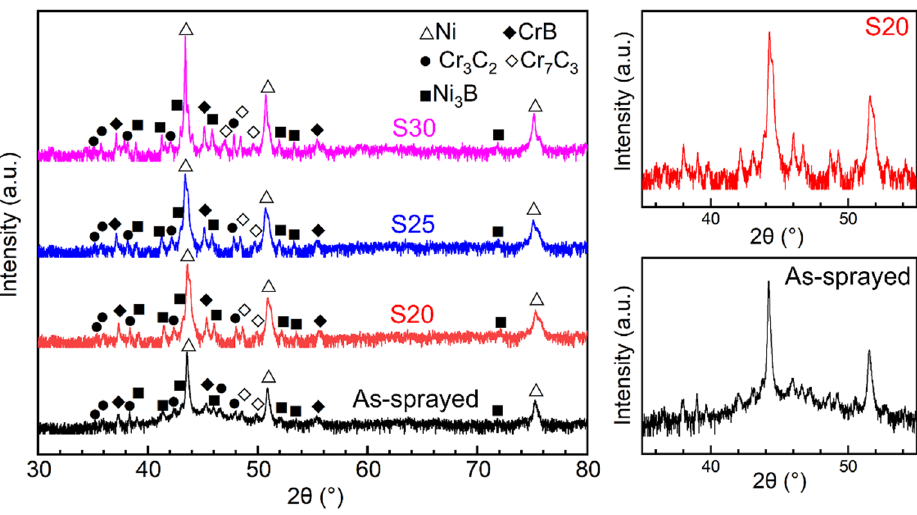
Figure 1. XRD patterns of all coating samples. The two figures on the right are the magnified view of the XRD patterns of the as-sprayed and S20 between 35 ◦ and 50 ◦ . S20, S25, and S30 indicate the as-sprayed NiCrBSi coatings remelted at 20 kW, 25 kW, and 30